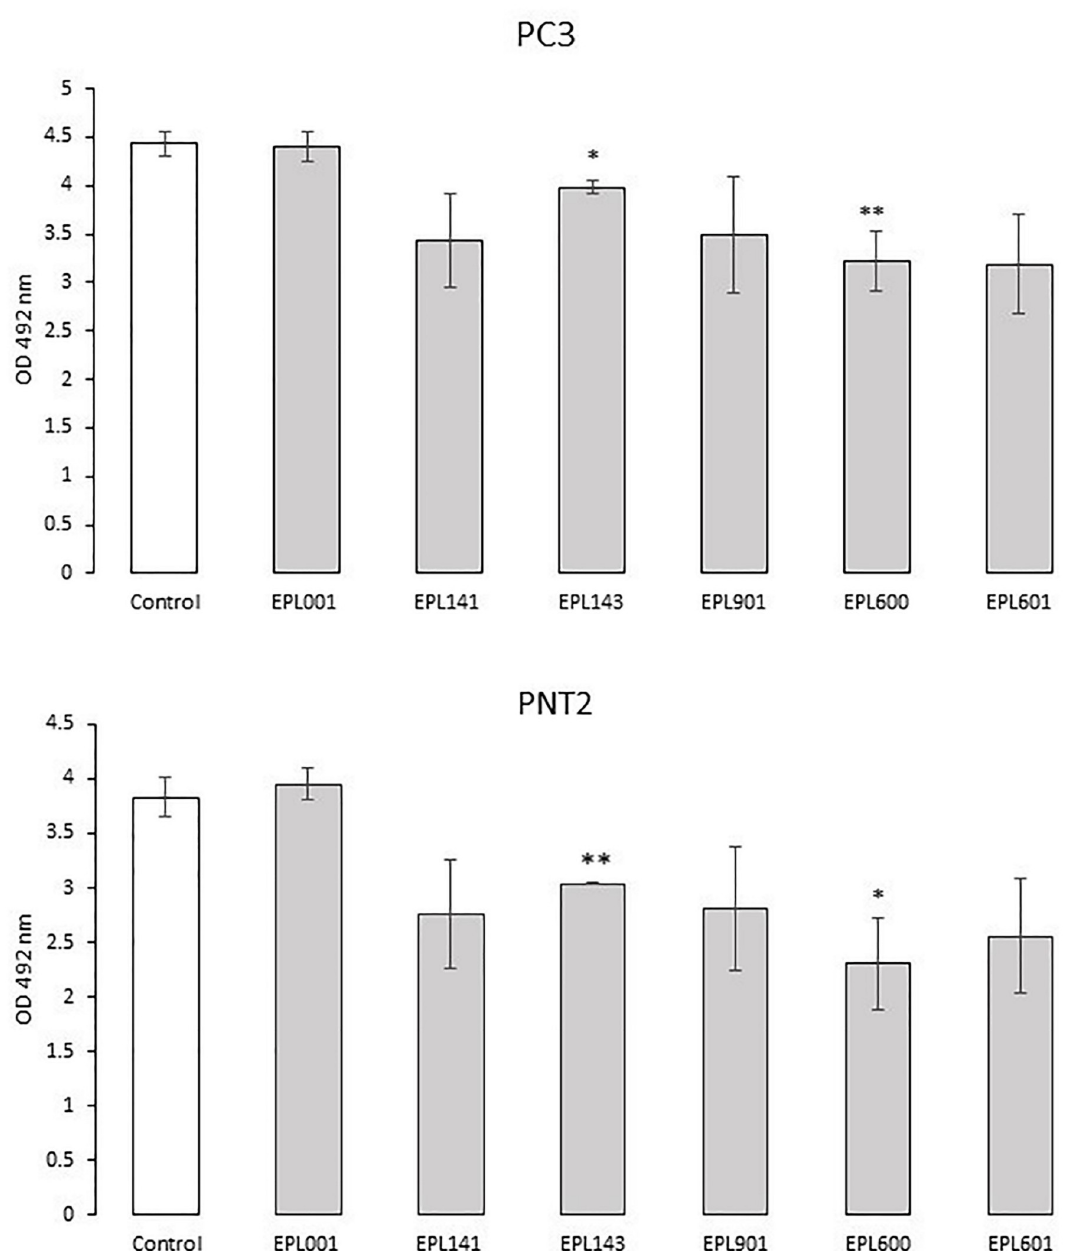
Fig 5. Effects of a range of peptides on human prostate cancer cell growth in vitro. Assays involved a range of peptides from 14mers down to 6mers (Table 1), with viable cells assessed using a 96-well plate MTS colorimetric assay. Absorbance measured at 492 nm. Cells were seeded at 8,000 per well and grown for 27h. Peptides were administered at the outset to a final concentration of 30 μ M (in 2 μ l) to samples in triplicate. Controls received buffer. Data are OD mean +/- SEM, with statistical analysis by two tailed t-test . � p < 0.05; �� p <